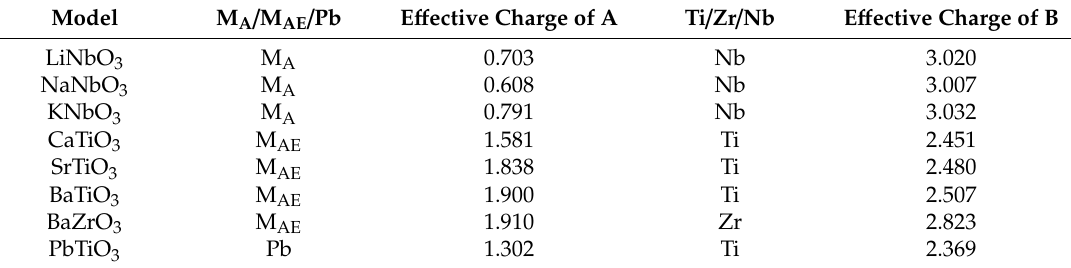
Figure 4. Histograms of the effective charges of the cations of double simple perovskites ABO 3 . The values in Table 5 were used. Table 5. Effective charges of the cations of the ABO 3 double perovskites.